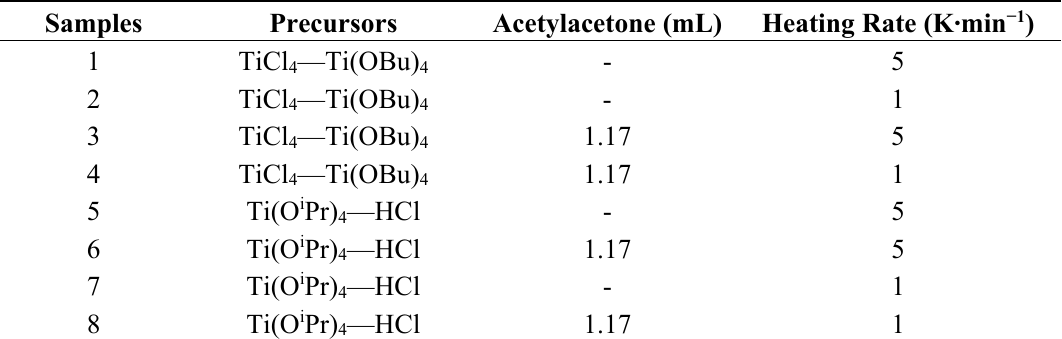
Table 1. Synthetic parameters. Used in the preparation of mesoporous titania samples.